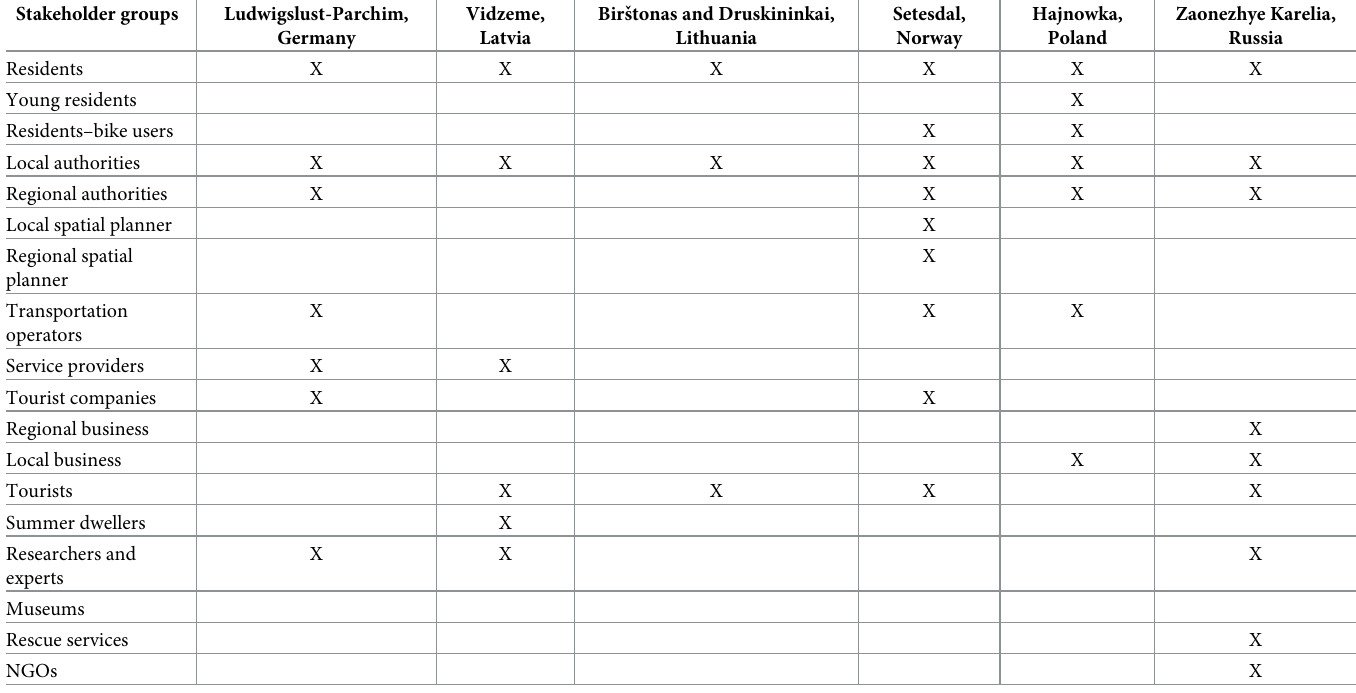
Table 2. Stakeholder groups identified in six regional stakeholder involvement strategies. Stakeholder